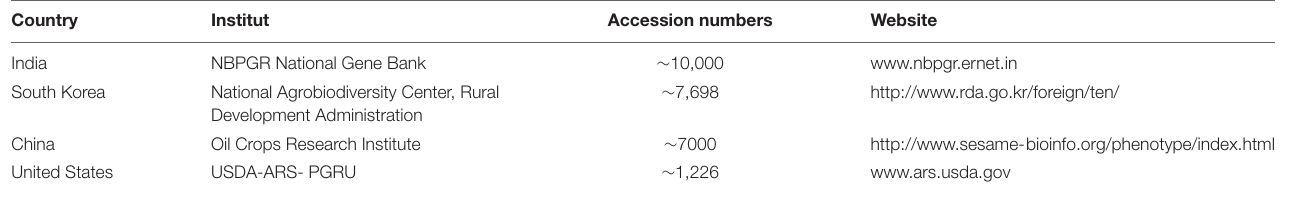
TABLE 2 | List of worldwide major genebanks available for sesame species.